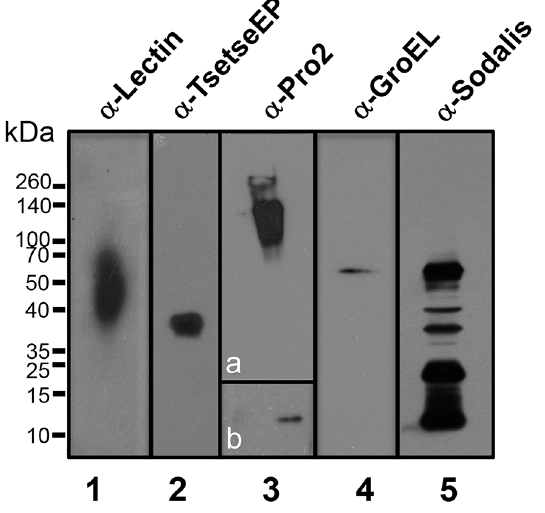
Figure 3. Western blotting analysis of tsetse PM proteins. Homogenates from , 10 PM equivalents were loaded per lane and after transferred to PVDF separately probed against an anti-tsetse lectin antibody (lane 1), anti-procyclin mAb 247 (lane 2), anti-Pro2 mAb 4A2 (lane 3), polyclonal anti-GroEL mAb 1H1 (lane 4) and polyclonal anti- Sodalis (lane 5) and developed by chemiluminiscence.